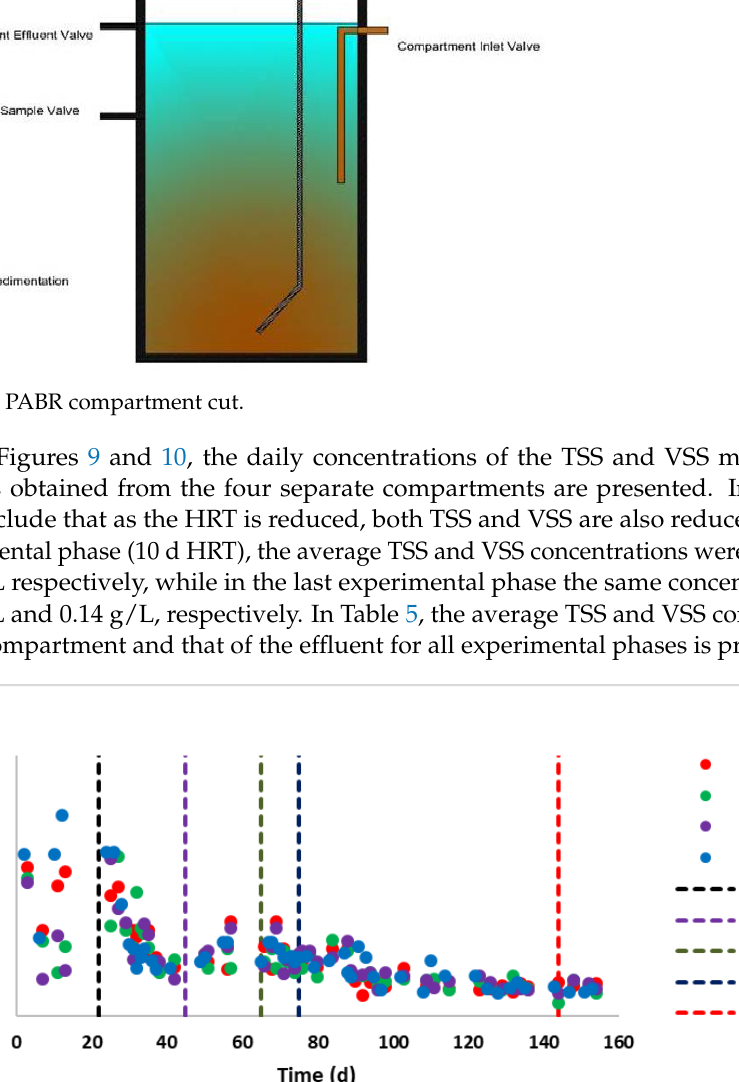
Figure 8 . PABR compartment cut.